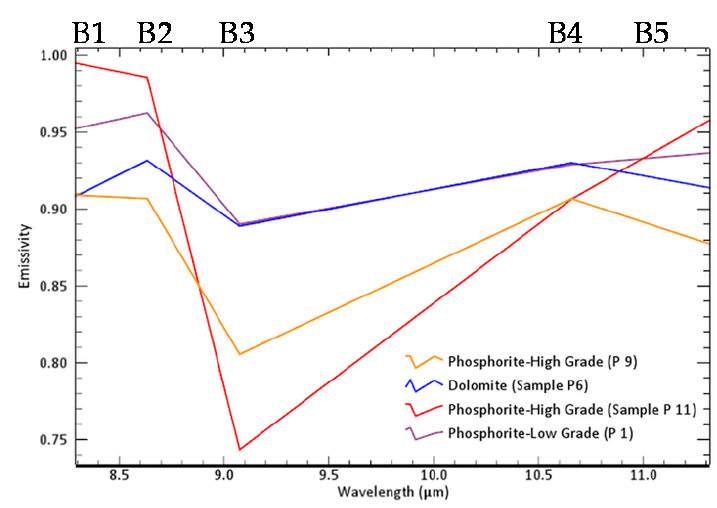
Figure 7. ASTER resampled spectra of representative samples of phosphorite and dolomite. Wavelength positions of five TIR bands of ASTER are also shown (B1 to B5).